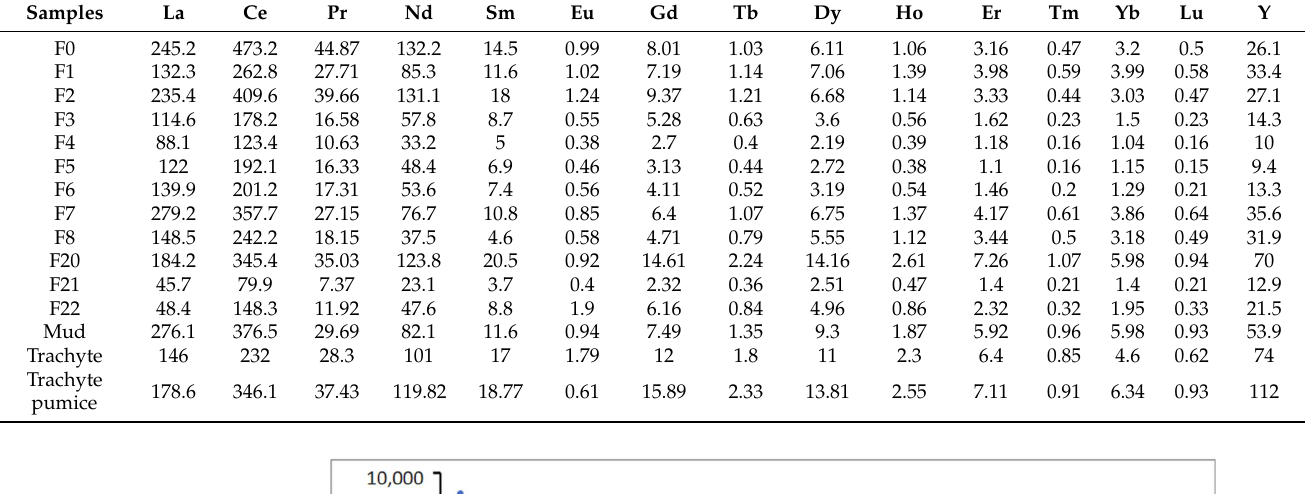
Table 4. Rare earth elements concentration (ppm) of the analyzed samples.